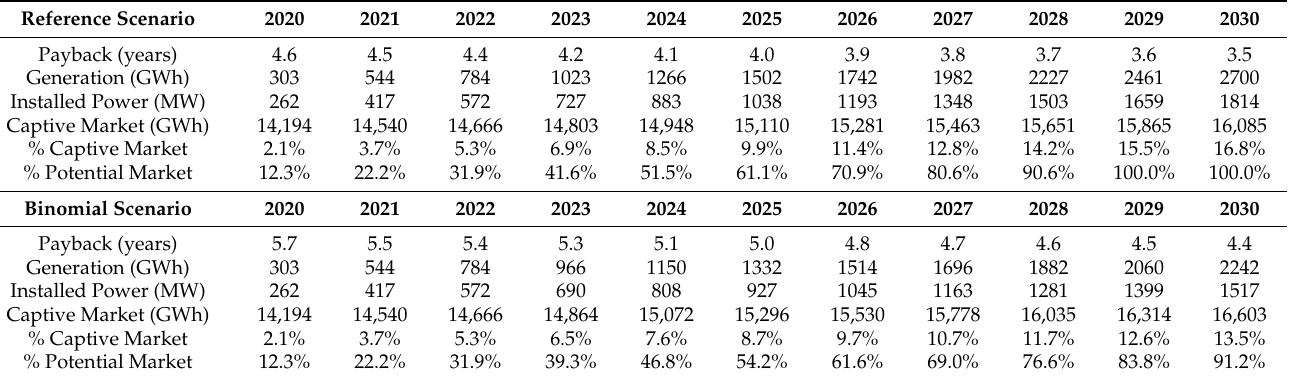
Table 6. MMDG expansion by Enel Goi á